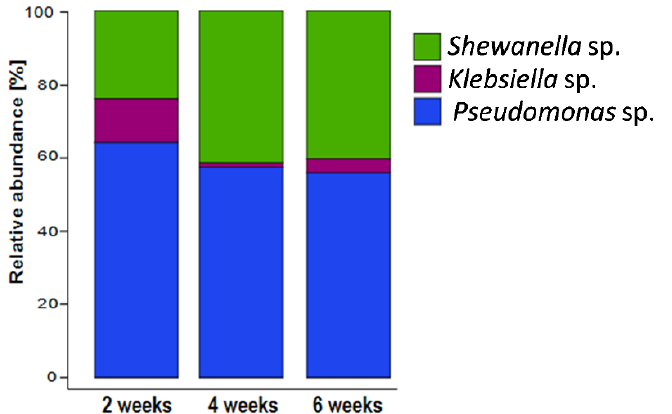
Figure 9. 16S rRNA-based microbial community composition of biofilms showing the mean relative abundances of each microbial taxa. Data are derived from the average abundance of two technical and two experimental replicates.